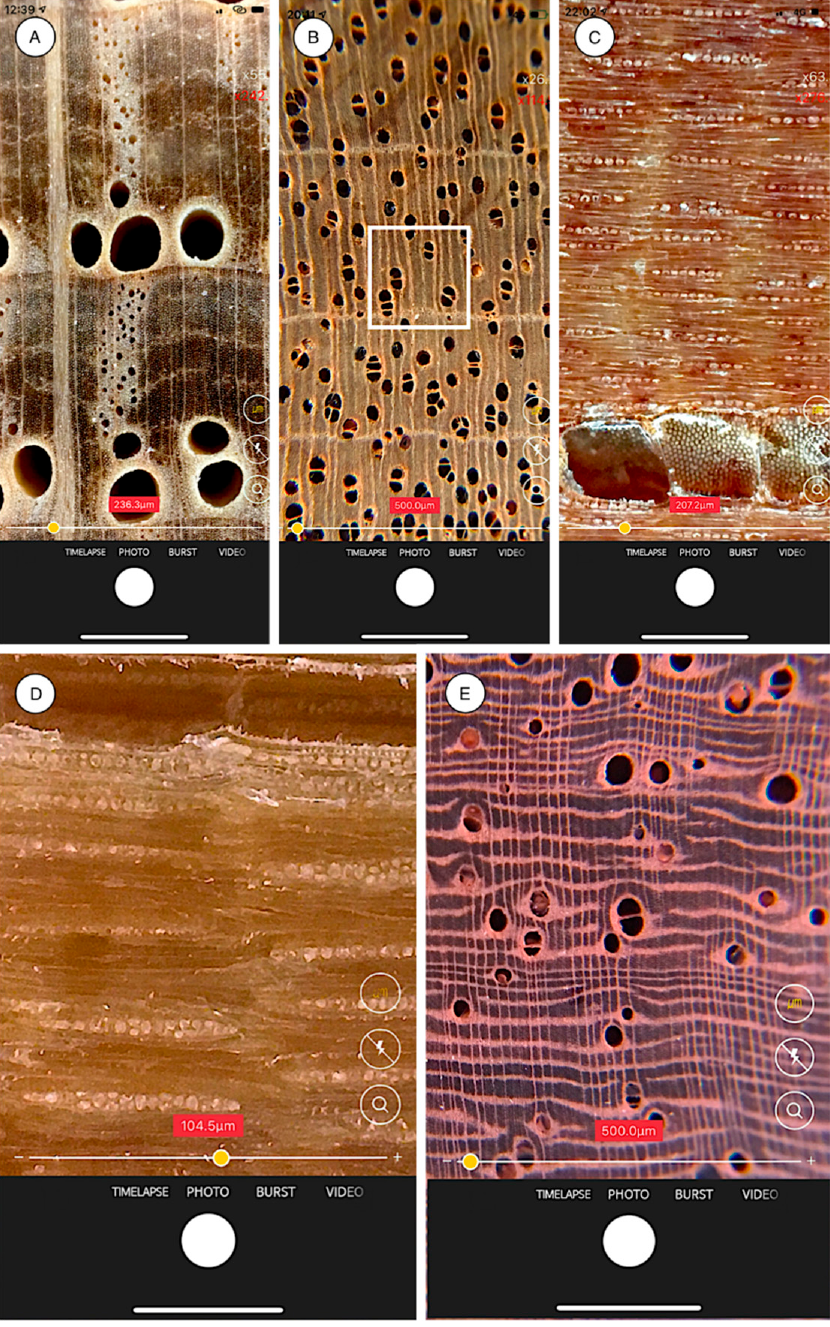
Figure 12. Biometry. ( A ) Tangential diameter of vessel lumina ( Quercus mongolica ). ( B ) Vessels per square millimetre ( Cedrela odorata ). ( C ) Vessel element length ( Pterocarpus santalinus ). ( D ) Ray height ( Dipteryx panamensis ). ( E ) Rays per millimetre ( Dalbergia stevensonii ). Figures 12C,D are rotated 90° because the mobile application does not permit rotation of the scale.